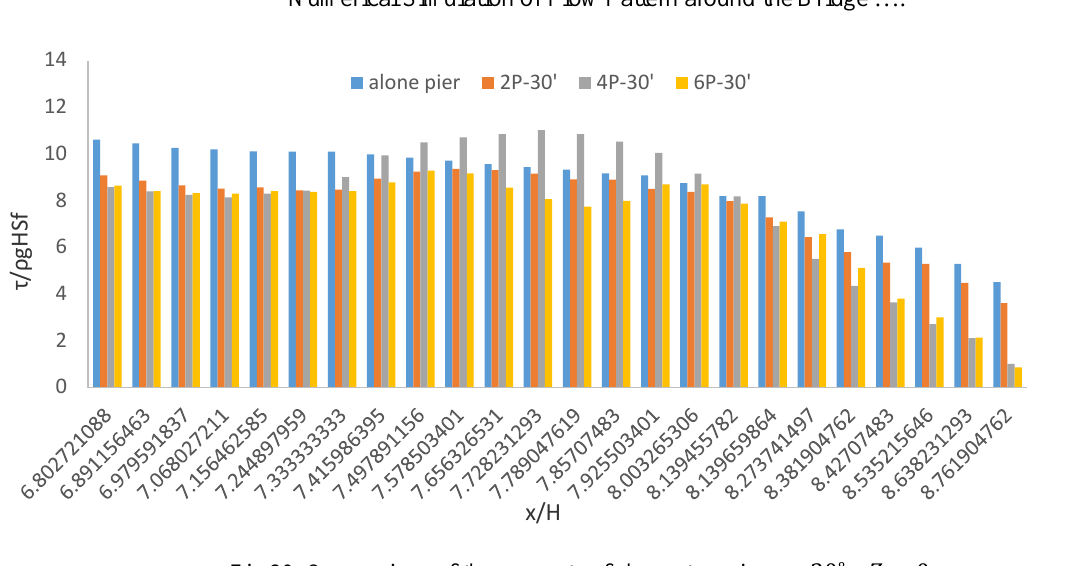
Fig 20. Comparison of the amounts of shear stress in 𝛼 = 30˚ , 𝑍 = 0 Table 7. The maximum shear stress and its distance from pier in various modes of submerged vanes maximum shear stress Location of the 𝑵 ( ) 𝒎 𝟐